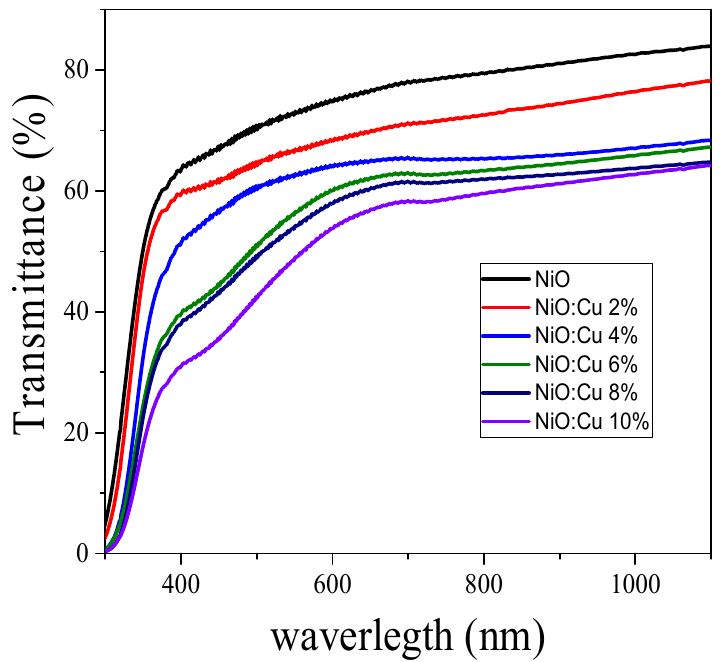
Figure 4. Transmittance spectra of pure and Cu-doping NiO films.